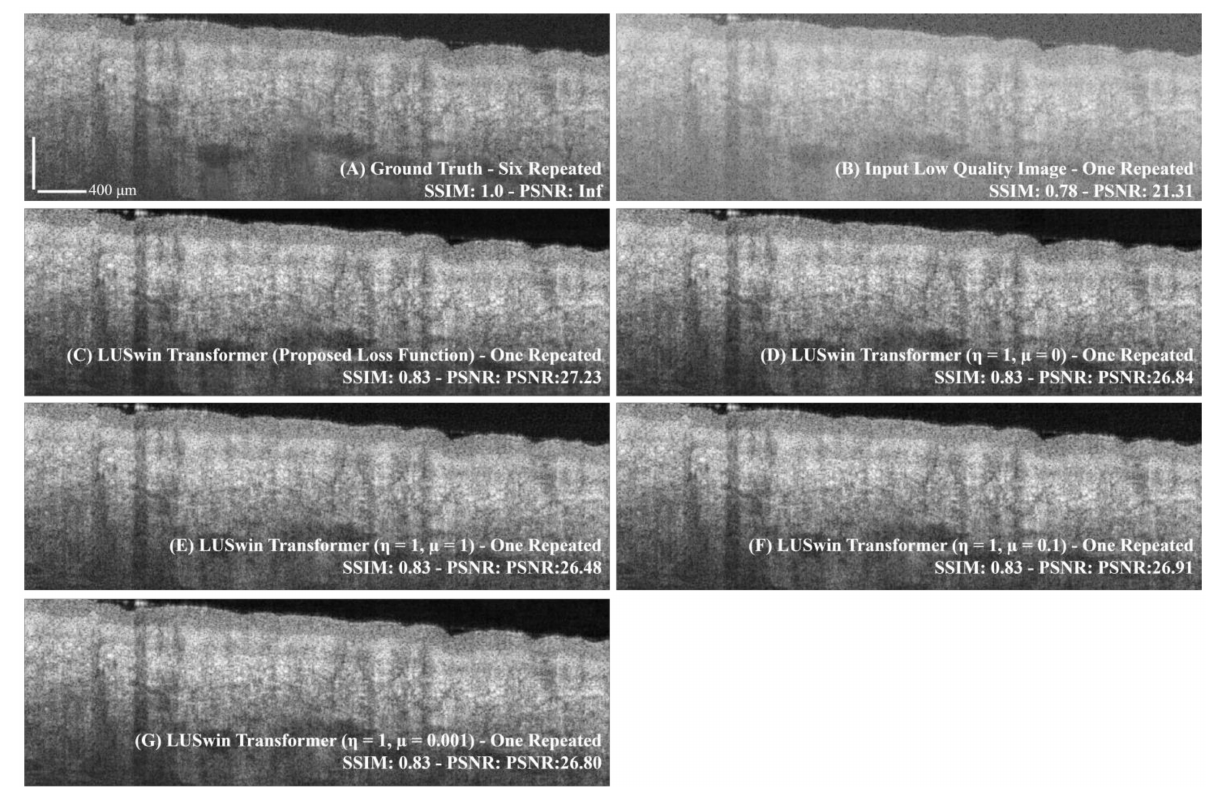
Figure 5. The visual comparison between the different utilization of the loss function. The image is selected from participant #014, representing the neural network performance on the palm thenar.